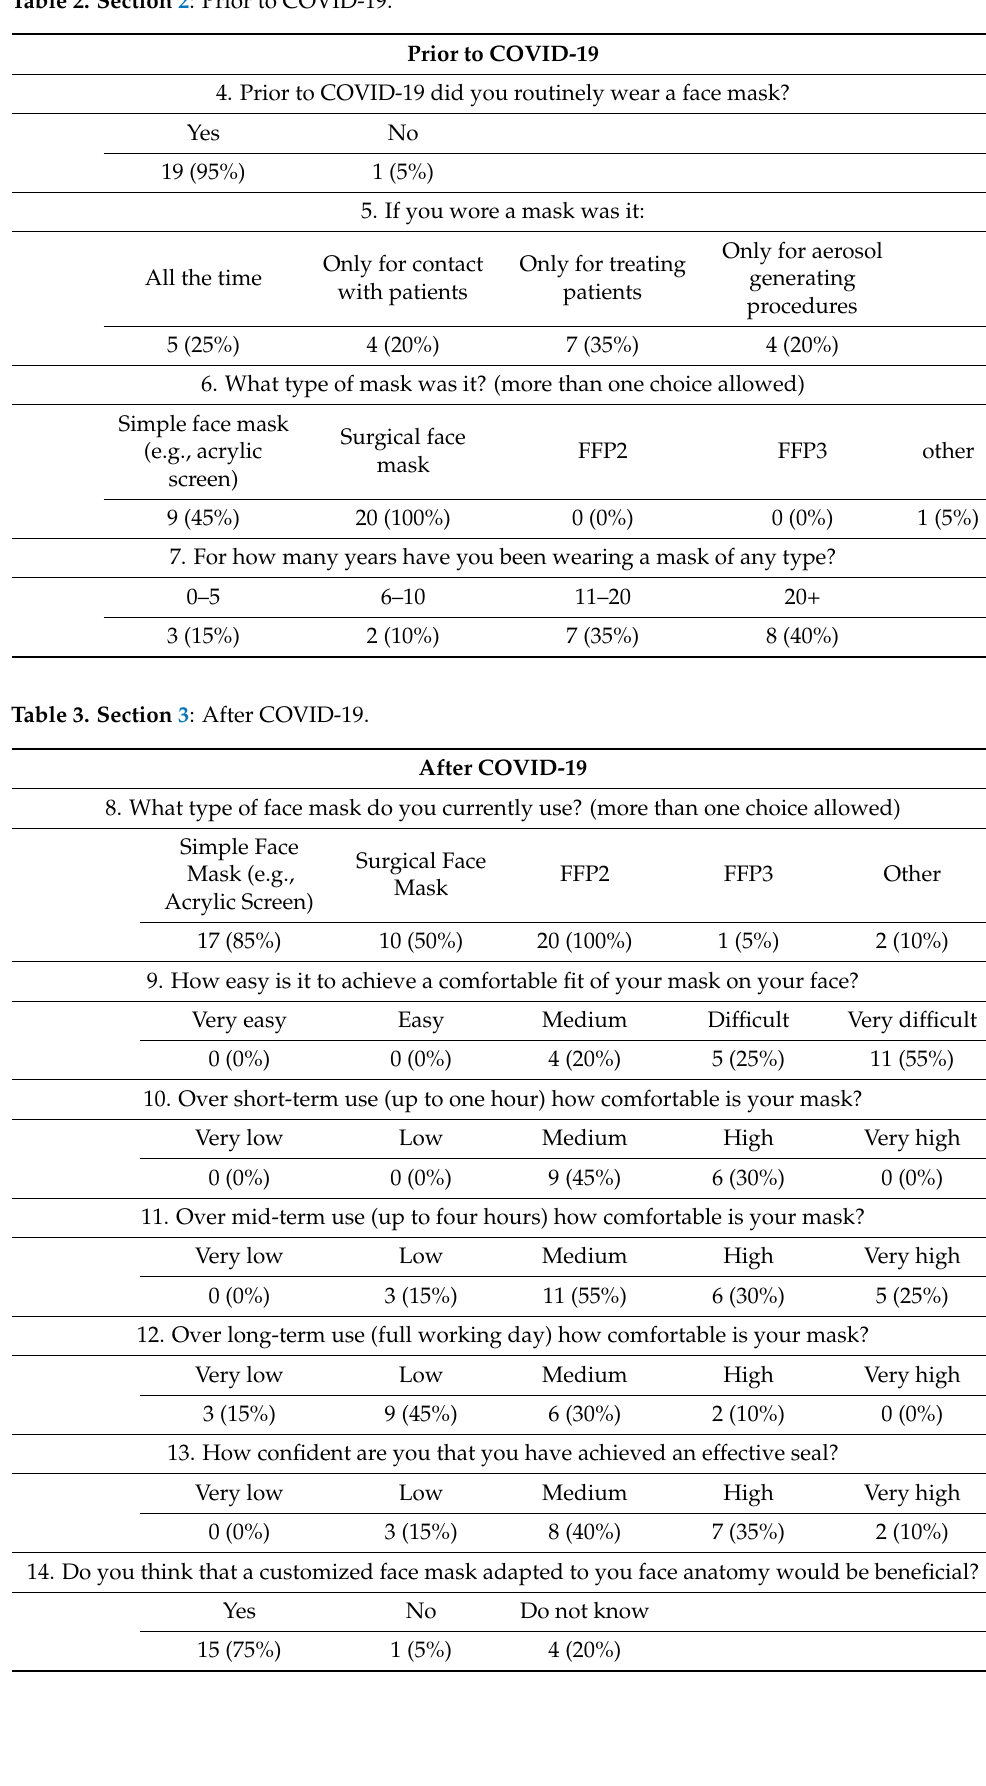
Table 2. Section 2 : Prior to COVID-19.